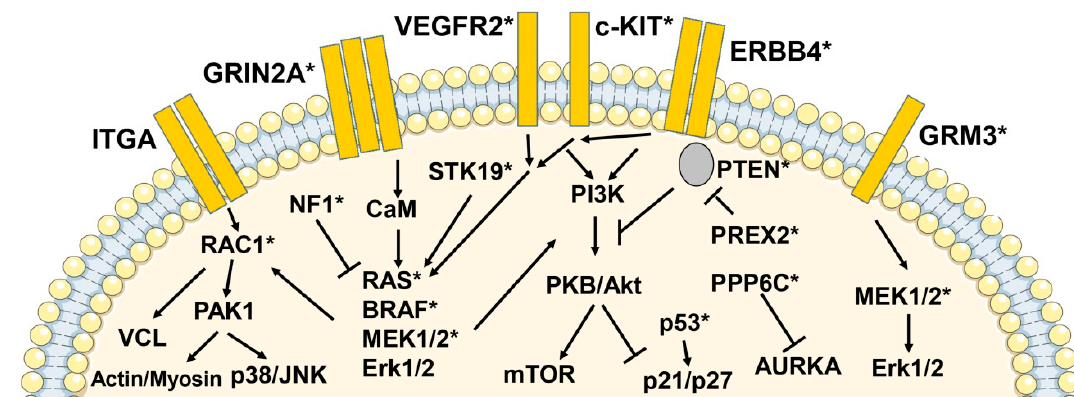
Figure 2. Schematic representation of signaling pathways with activating and inactivating mutations or gene amplifications in melanoma. In large-scale sequencing studies using next-generation sequencing a number of activating and inactivating mutations and gene amplifications of genes encoding for intracellular signaling molecules could be identified, apart from BRAF and NRAS . A schematic representation of these molecules and pathways is shown. of mutated or amplified genes are indicated by